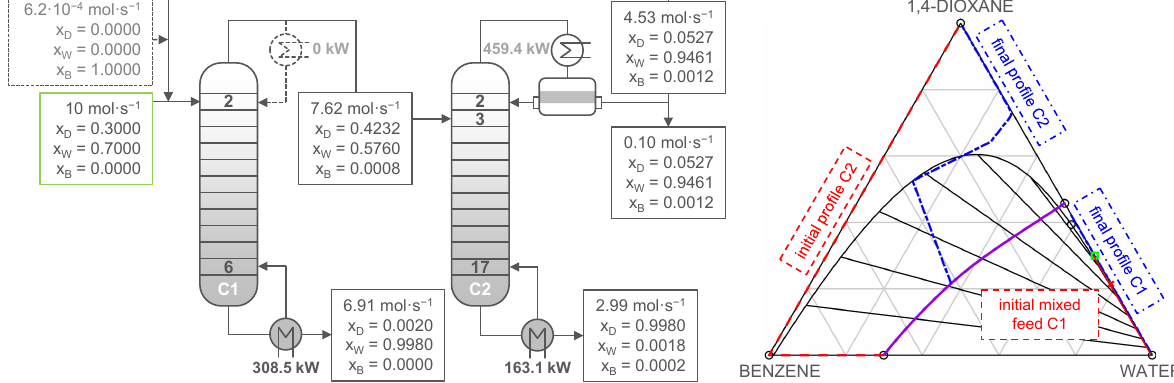
Figure 11. Optimal process design for the separation of 1,4-dioxane and water using benzene as a solvent in a two-column heteroazeotropic distillation setup ( left ), including the initial and final liquid composition profiles of both columns in the corresponding Gibbs diagram ( right ). The initial composition profiles of columns C1 and C2 are plotted as red cross and dashed line, respectively, while the final composition profiles of both columns are plotted as blue dot-dashed lines. The feed composition is indicated by a green square and all singular points as well as the liquid-liquid critical point are marked as black circles.